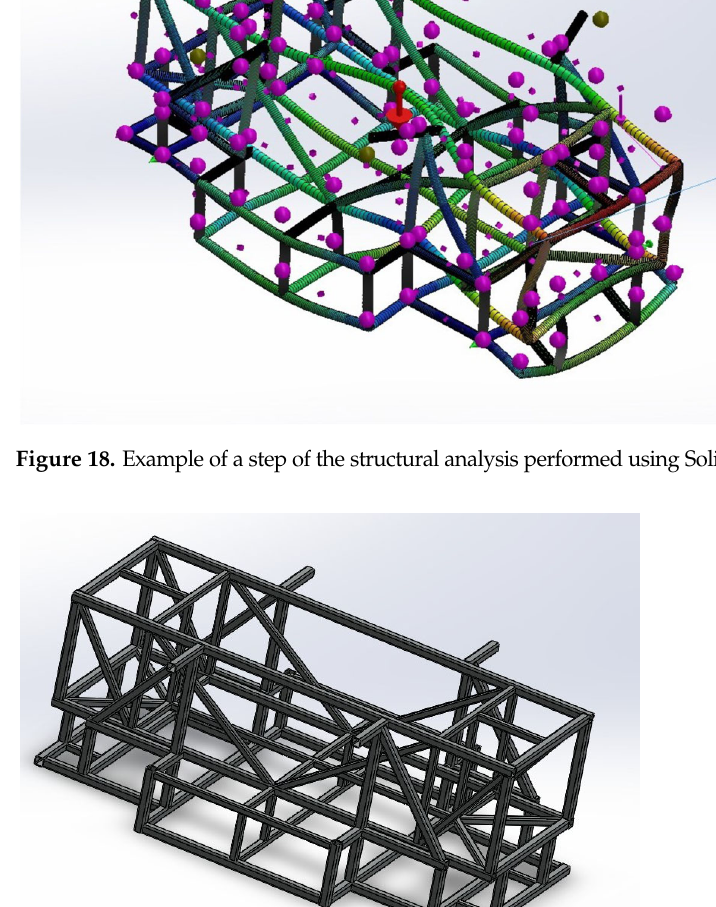
Figure 19. Complete chassis structure.